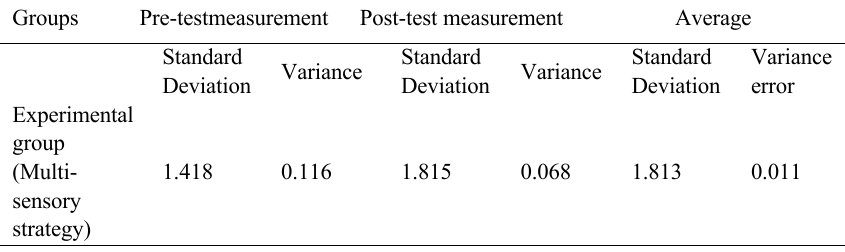
The results of ANCOVA of the variable groups (traditional, multi - sensory strategy) Groups Pre-testmeasurement Post-test measurement Average Standard Standard Standard Variance Variance Variance Deviation Deviation Deviation error Experimental group (Multi- 1.418 0.116 1.815 0.068 1.813 sensory strategy)